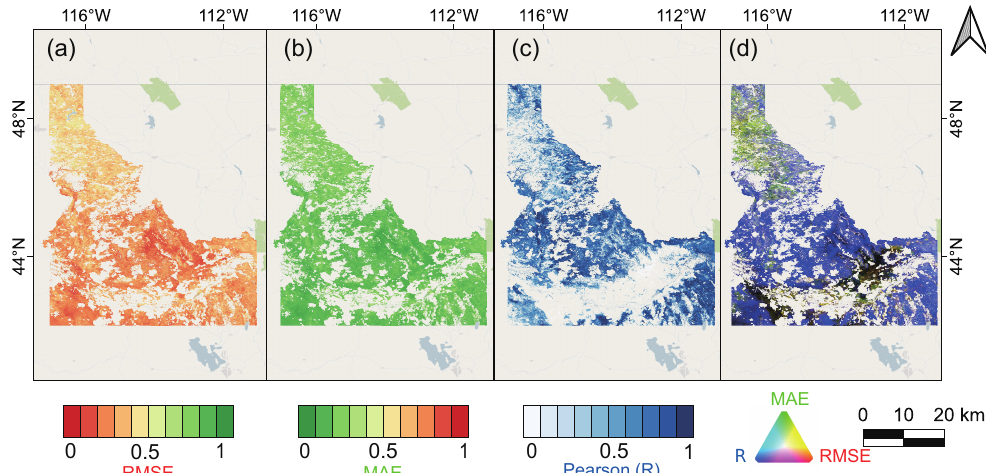
Figure 4. Spatial variation of the goodness of fit indices for all months from 2014 to 2018. ( a ) RMSE, ( b ) MAE, ( c ) Pearson’s R at a significance level of 0.05, and ( d ) RGB composite image of the three metrics (Red: RMSE, Green: MAE, and Blue: Pearson’s R). Blue colors in panel ( d ) refer to areas having high accuracy with low RMSE and MAE, and high Pearson’s R, yellow colors suggest decreased accuracy with higher RMSE and MAE and lower Pearson’s R, and black colors indicate areas having few vegetation covers and showing low RMSE, MAE, and Pearson’s